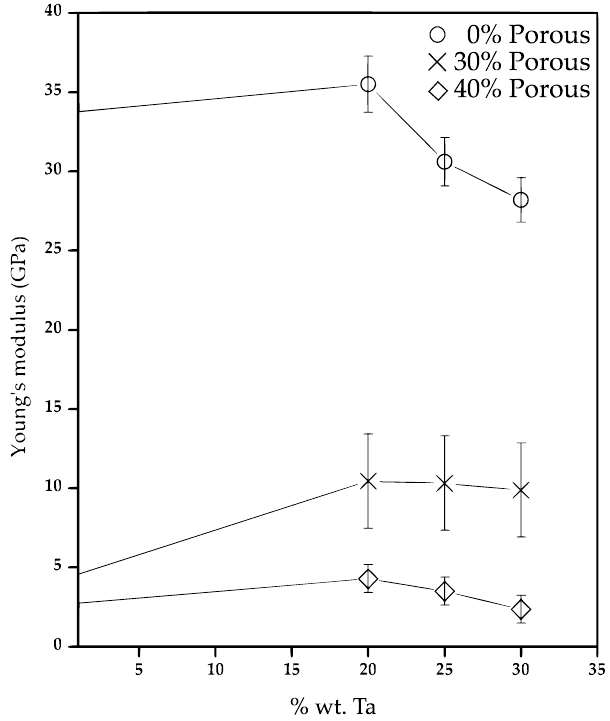
Figure 12. Young’s modulus as a function of the weight% of Ta for samples with and without additional porosity added. Table 3. Mechanical properties of Ti-Ta alloys and human bones reported in the literature.